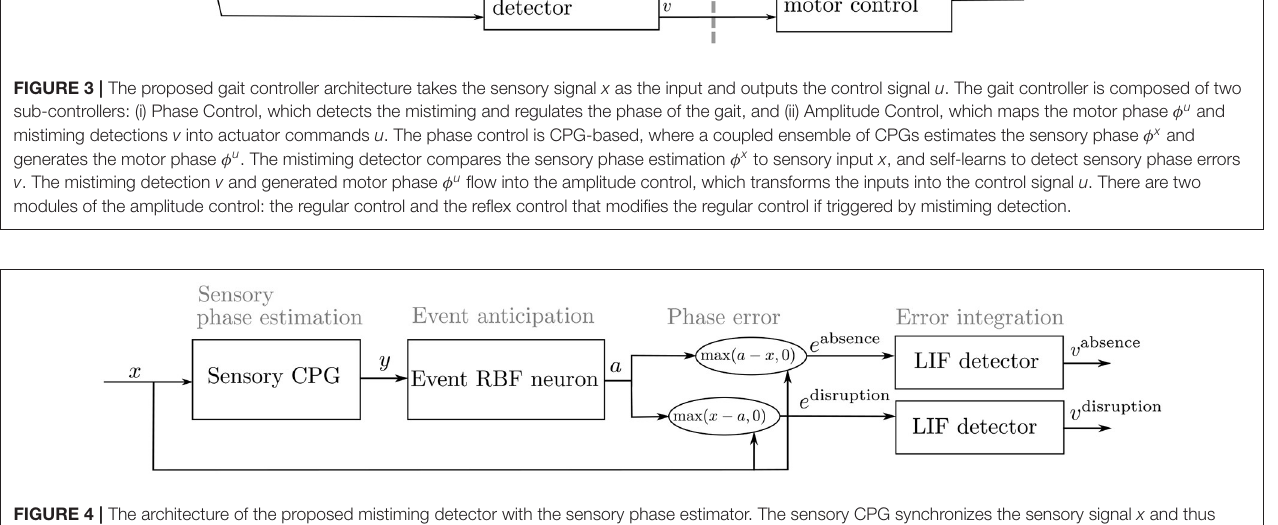
FIGURE 4 | The architecture of the proposed mistiming detector with the sensory phase estimator. The sensory CPG synchronizes the sensory signal x and thus estimates the sensory phase φ x . The RBF neuron learns the phase during which the event occurs; the RBF neuron is active, a ≈ 1, during the anticipated event. A difference between the RBF neuron activation and sensory signal gives two types of mistiming error: e absence and e disruption . Each error excites its respective LIF neuron, where each LIF neuron learns the activation threshold during the regular motion. If the sensory signal contains disturbances, the LIF activation v exceeds the threshold and fires. The LIF firing detects the